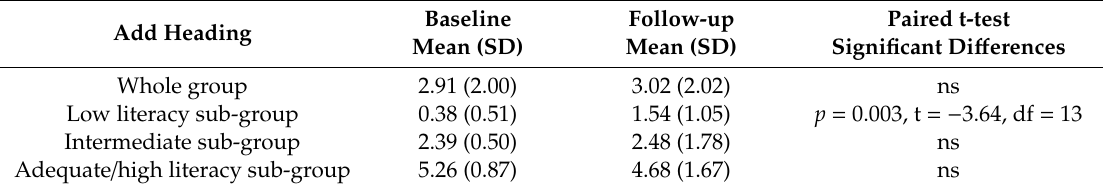
Table 4. Newest Vital Sign UK (NVS-UK) baseline and follow-up mean scores for the whole group ( n = 55) and sub-groups categorized by baseline scores into low (0–1) ( n = 13), intermediate (2–3) ( n = 23), and adequate / high literacy ( > 3) ( n = 19), with paired t-test significant di ff erences.